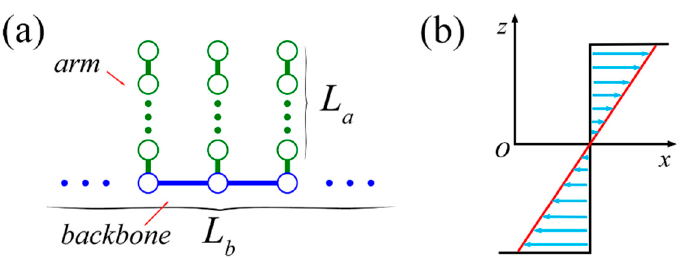
L . L and arm length b a